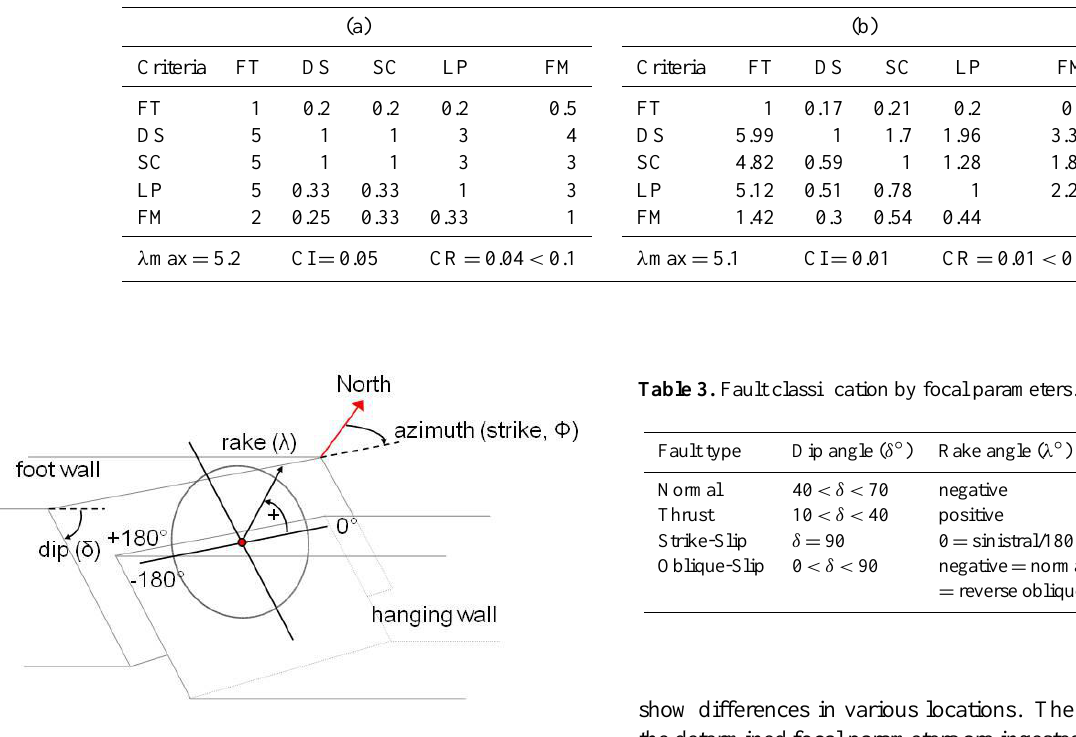
Table 3 Fault classification by focal parameters 7